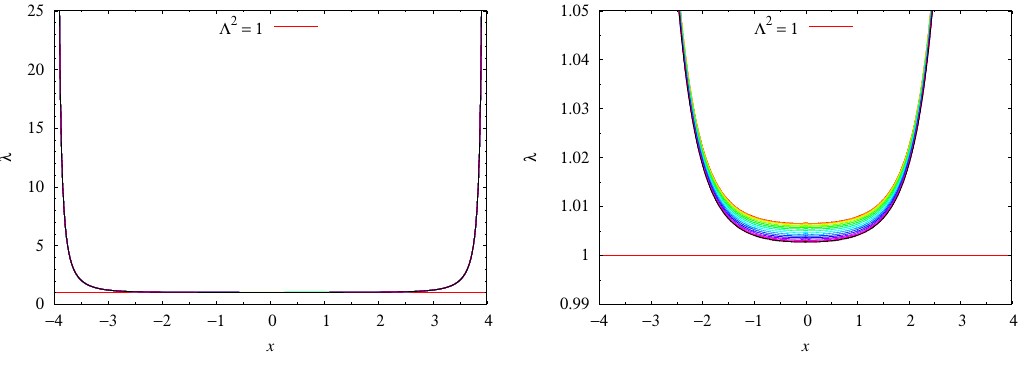
Figure 18. The same as (cid:12)gure 4 but for L = 8.